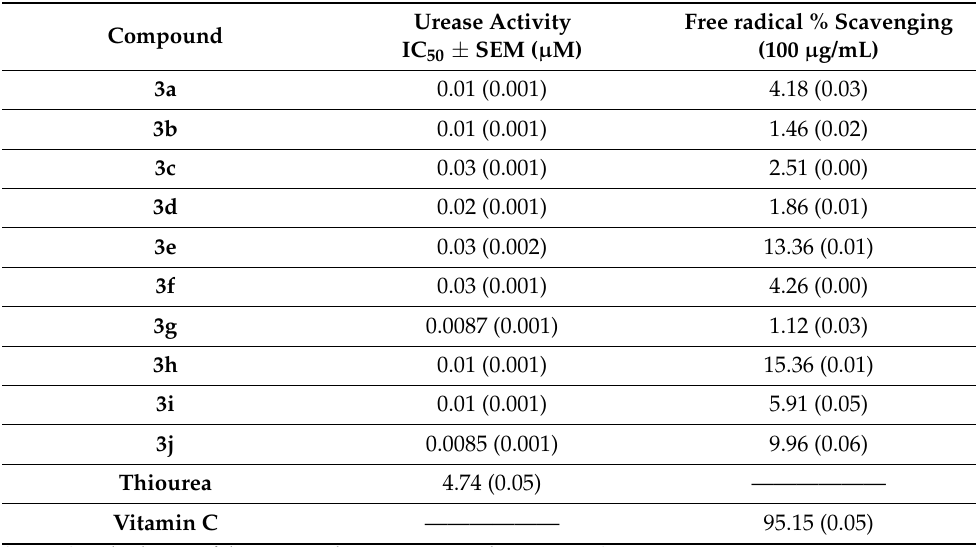
Table 1. Urease inhibitory activity and free radical % scavenging of compounds ( 3a – j ).